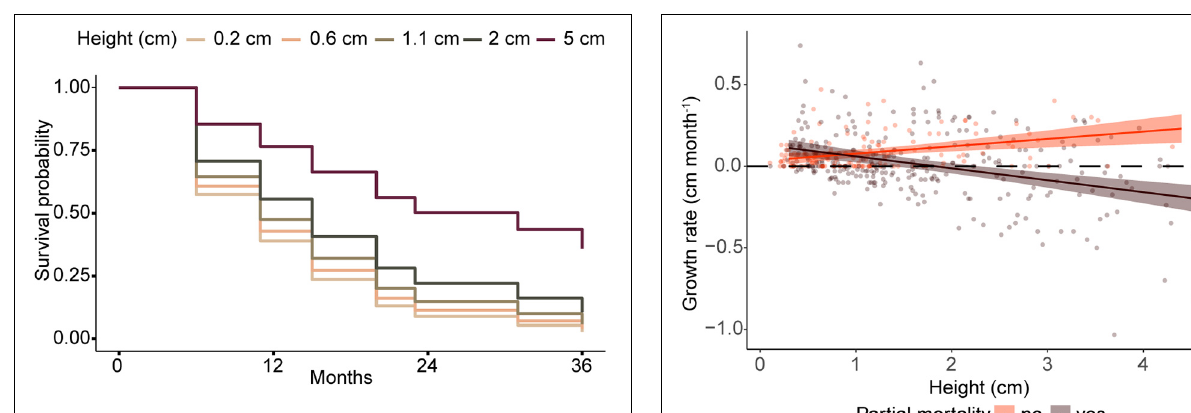
FIGURE 8 | Kaplan-Meier curves depicting survivorship of colonial recruits of different sizes over time (assuming recruits do not change in size). Sizes correspond to the 25th, 50th, 75th, and 100th percentiles of colonial recruit heights in our areas of study. Confidence intervals are not depicted for visual clarity.